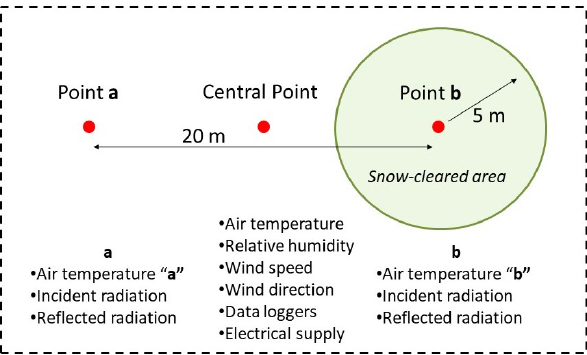
Figure 1. Experiment layout scheme. Points a and b host the pairs of identical thermometers and shields. The central point hosts aux- iliary equipment, data loggers and sensors for measuring quantities of